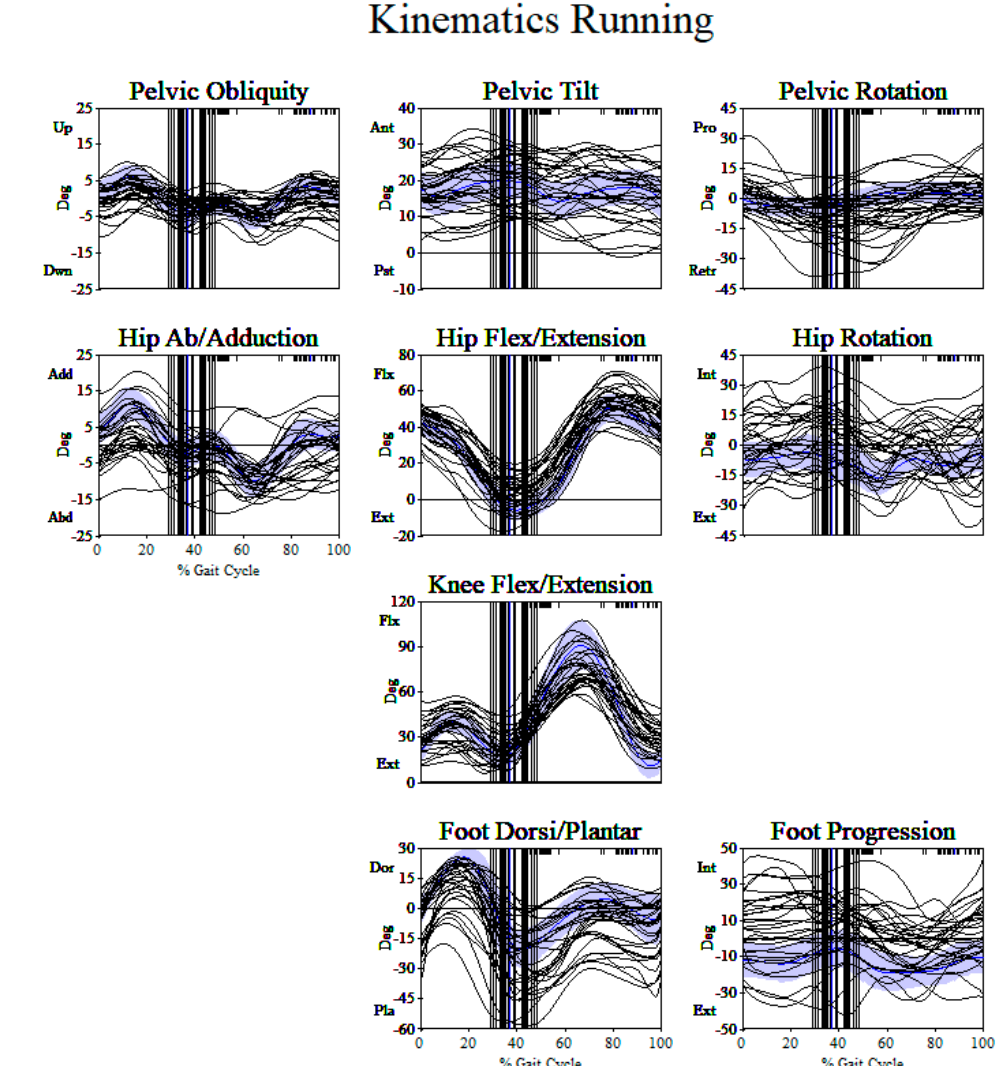
Figure 2. Running kinematics (left side only) for 30 participants from the Spokane center. Spokane center typically developing running kinematics are shown in shading. There are no consistent patterns of running from participant to participant. Variations from typically developing running are seen in both directions (e.g., increased flexion and extension in sagittal plane, increased internal and external rotation in the transverse plane).